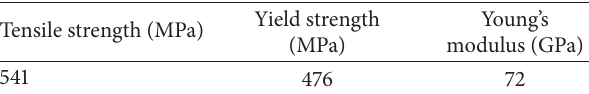
Table 1: Mechanical properties of 7050-T7451 aluminum